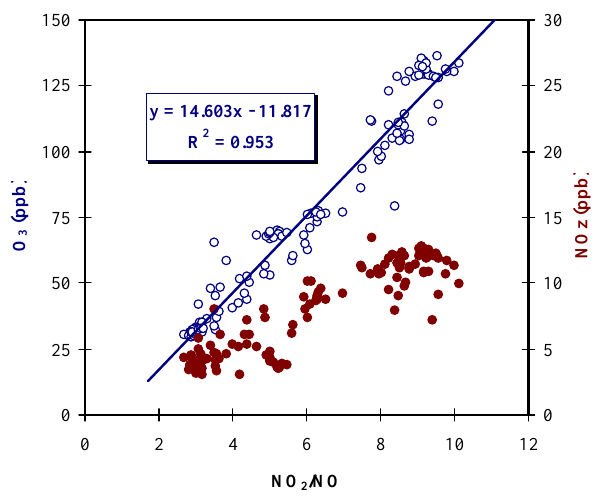
Fig. 5. Correlation of O 3 and NO z , respectively, versus the NO 2 /NO ratio for the period of 10:30–12:30, 3 August 2008. The linear regression is associated to the O 3 data. The increasing trend of NO z with the NO 2 /NO ratio is discontinued as NO 2 /NO > 8.